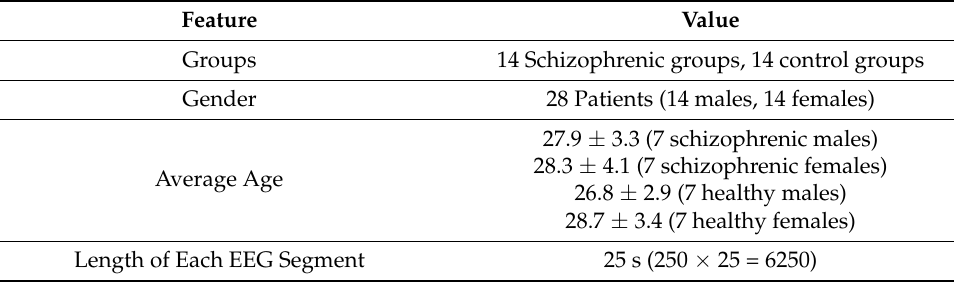
Table 2. Attributes of the data set used in this